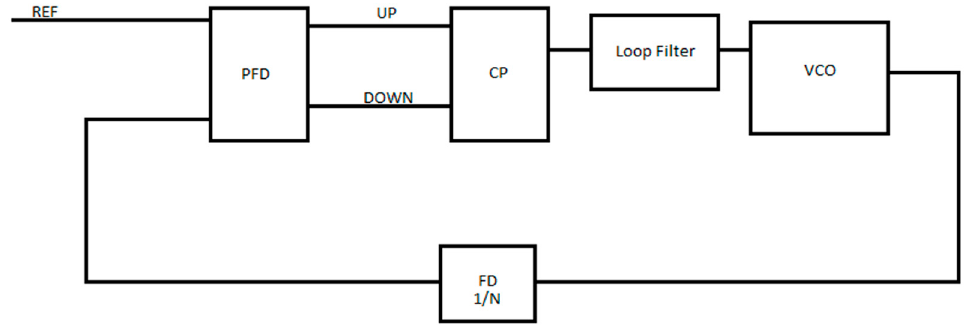
Figure 1. Block schematic of the Charge Pump Phase-Locked Loop (CP-PLL).